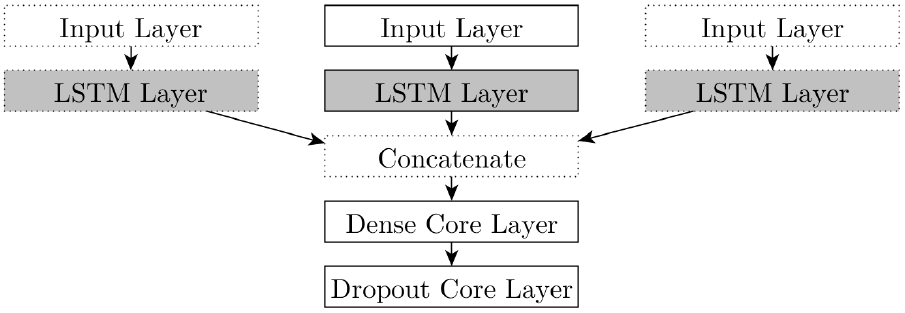
Figure 4. Layer design of simulation framework.